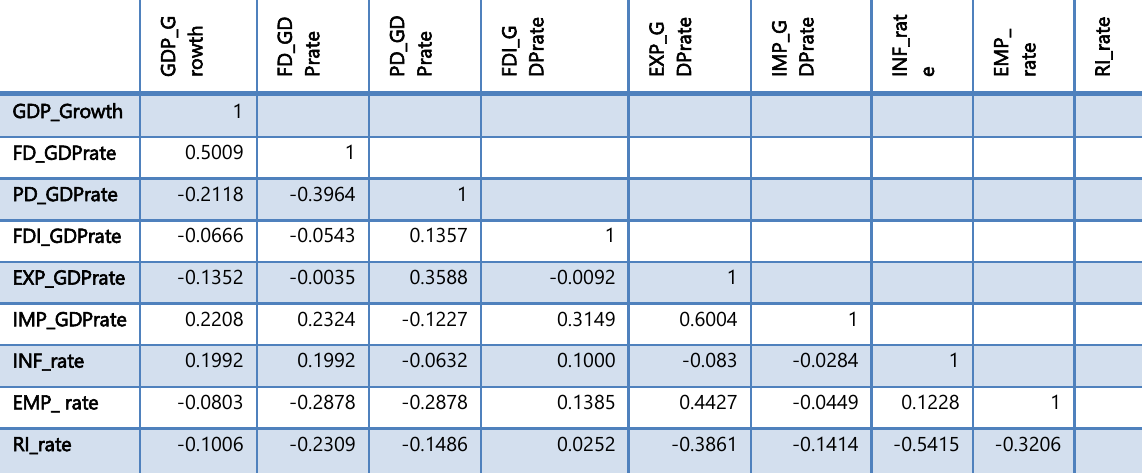
Table 3: Correlation Analysis (Source: Authors‟